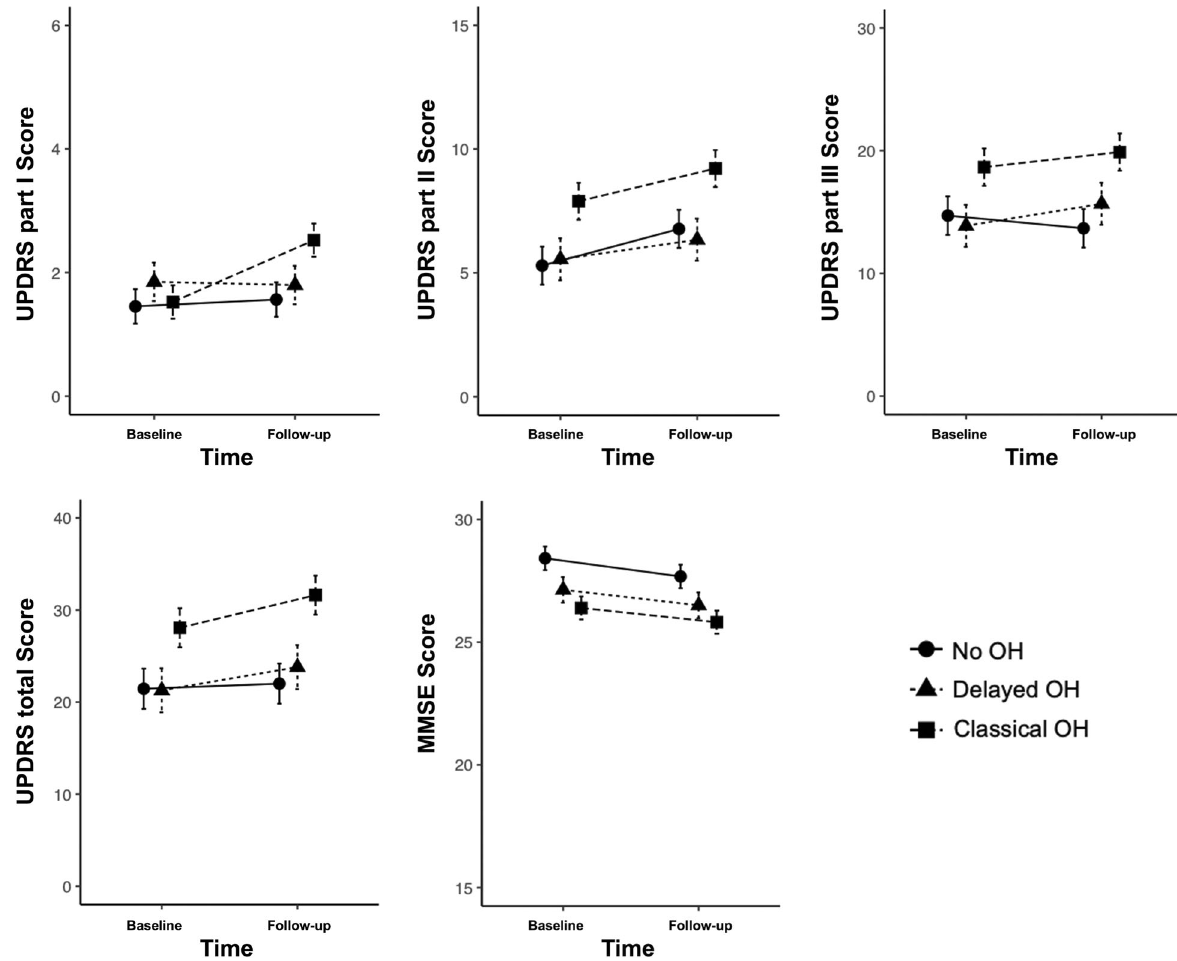
Fig. 2 Temporal progression of cognitive and motor severities across the groups. Error bars: standard error of the mean. UPDRS Uni fi ed Parkinson ’ s Disease Rating Scale, MMSE Mini-Mental Status Examination, OH orthostatic